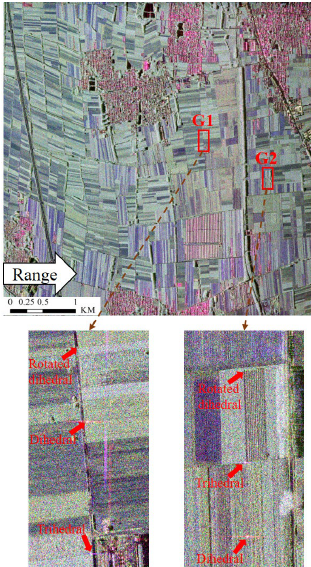
Figure 3 . Study area and location of